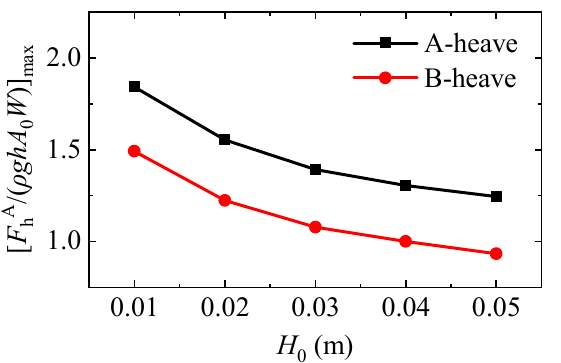
Figure 5. Variations of the normalized largest horizontal wave forces on Box A, [ F hA /( ρ ghA 0 W )] max , with respect to the incident wave height.